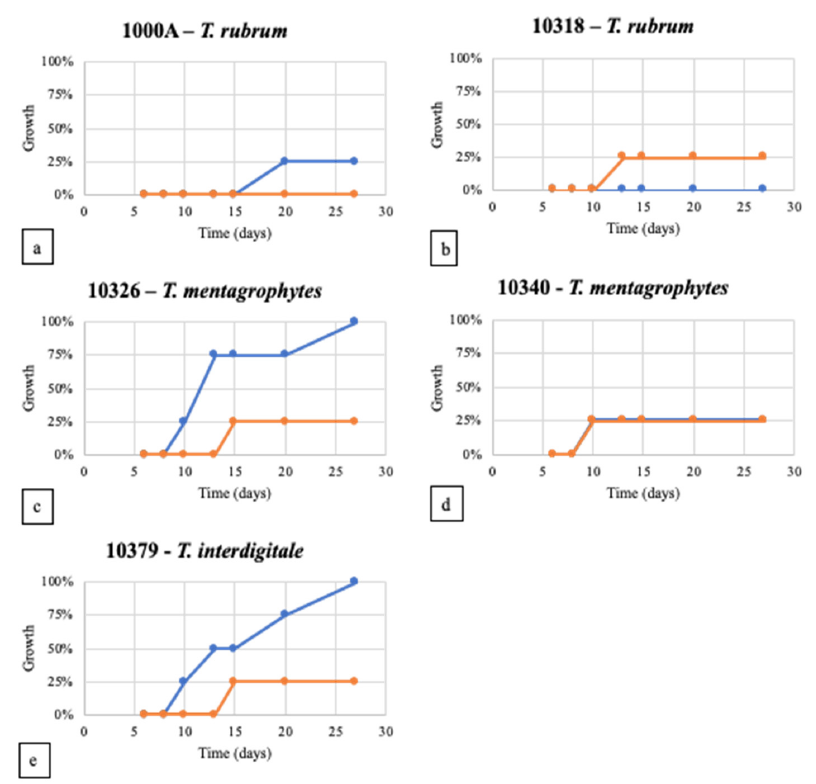
Figure 7. Membrane coverage percentage by T. rubrum 1000A ( a ) and 10318 ( b ), T. mentagrophytes 10326 ( c ), T. mentagrophytes 10340 ( d ), T. interdigitale 10379 ( e ) in WA (blue line) and ½ SDA (or- ange